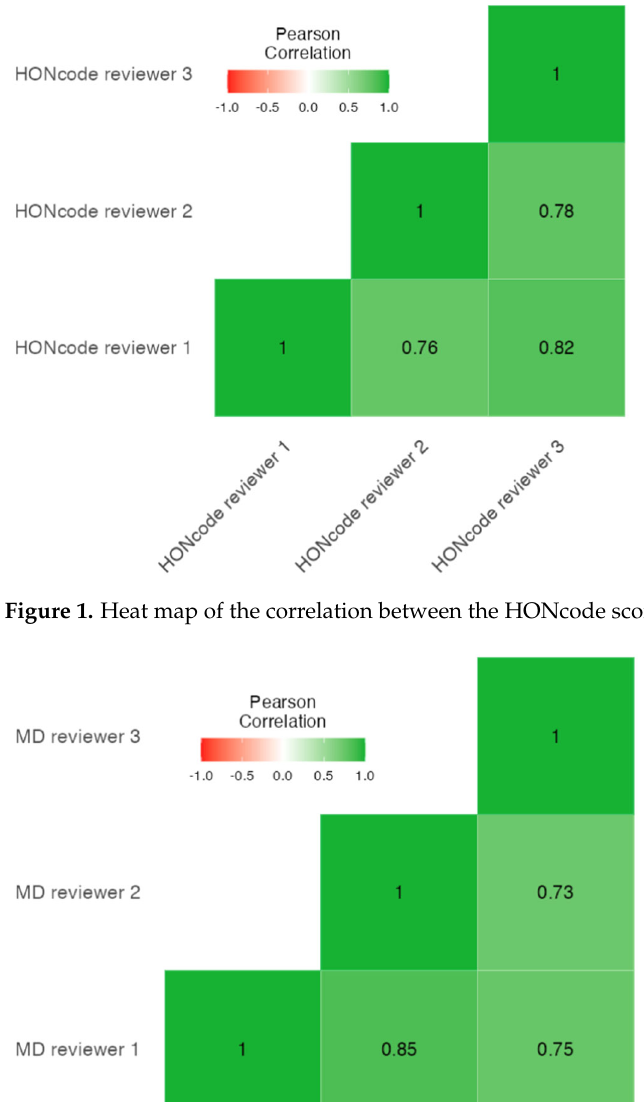
group but not between the two groups (Table